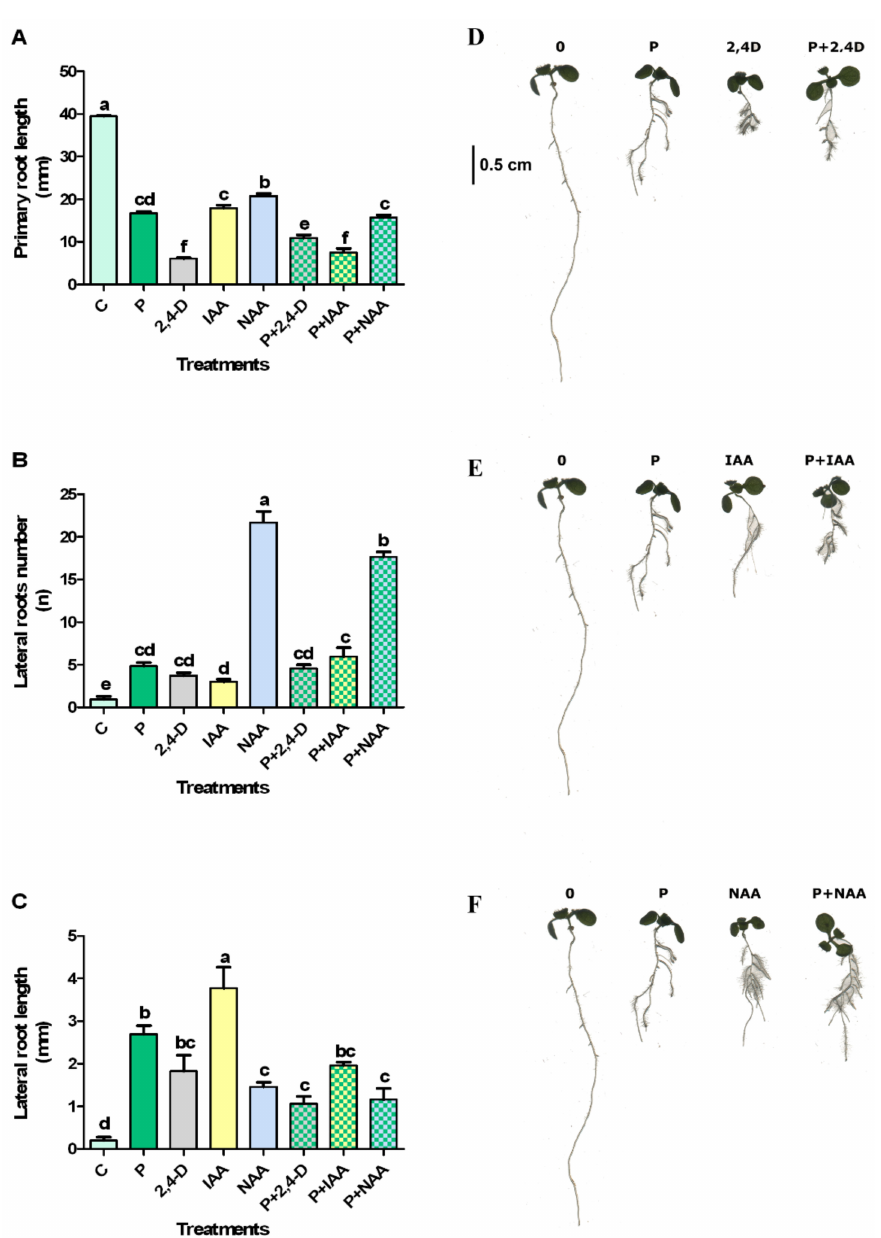
Figure 3. Primary root length ( A , D ), lateral roots number ( B , E ), and lateral root length ( C , F ) of Arabidopsis seedlings exposed to protodioscin (P) alone or in combination with auxins 2,4-D, IAA, and NAA (averaged data on the left side and representative image on the right side). Different letters indicate significant differences observed among treatments at p ≤ 0.05 (SNK’s test). N = 4. In particular, 2,4-D alone caused the highest inhibition on primary root length, but this negative effect was reduced in combination with protodioscin. By contrast, IAA and NAA combined with protodioscin increased their inhibitory effect, further reducing primary root growth (Figure